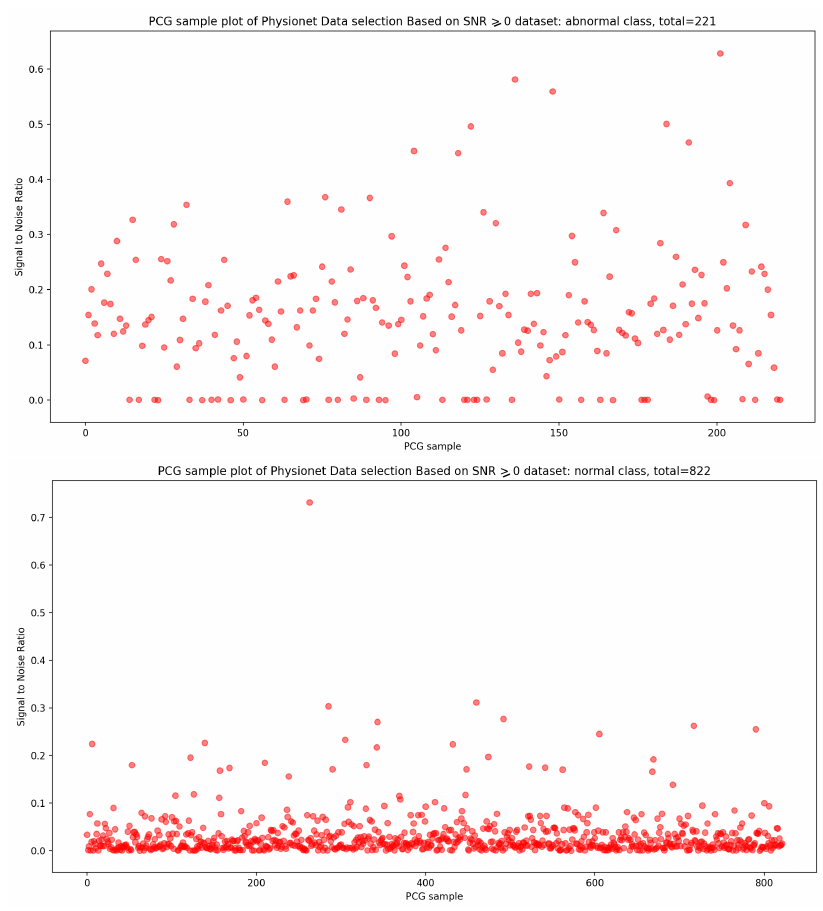
Figure 11. PCG samples distribution of normal and abnormal classes in function of SNR greater than or equal to